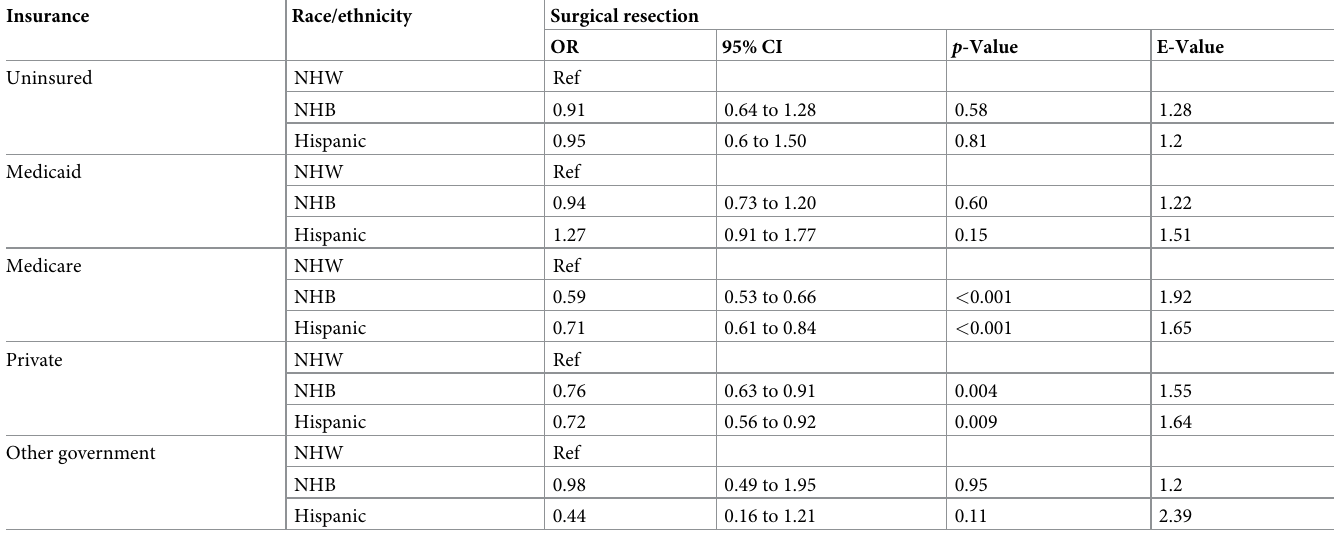
Table 5. Effect modification of insurance on race/ethnicity and surgical resection. Insurance